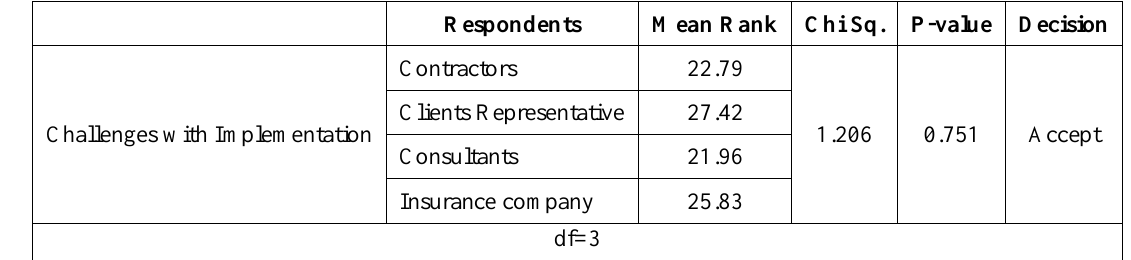
Table 4: Overall Comparison of participants perception of Challenges with Insurance Implementation in